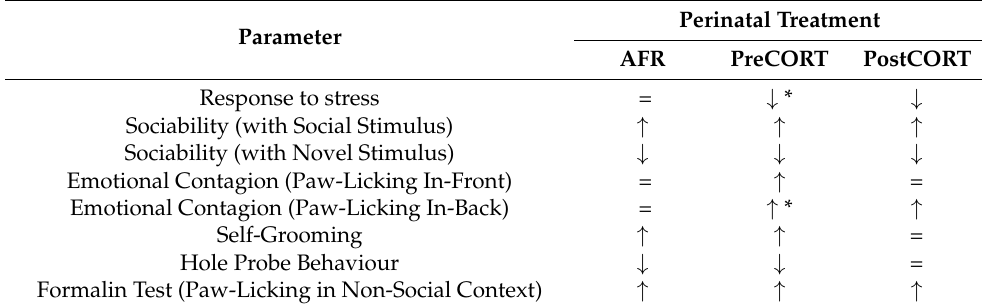
Table 1. Summary of the effects due to oxytocin administration on physiology and behaviour. AFR, PreCORT and PostCORT ( n = 8). Symbol * indicates a statistically significant increase ( ↑ ) or decrease ( ↓ ).